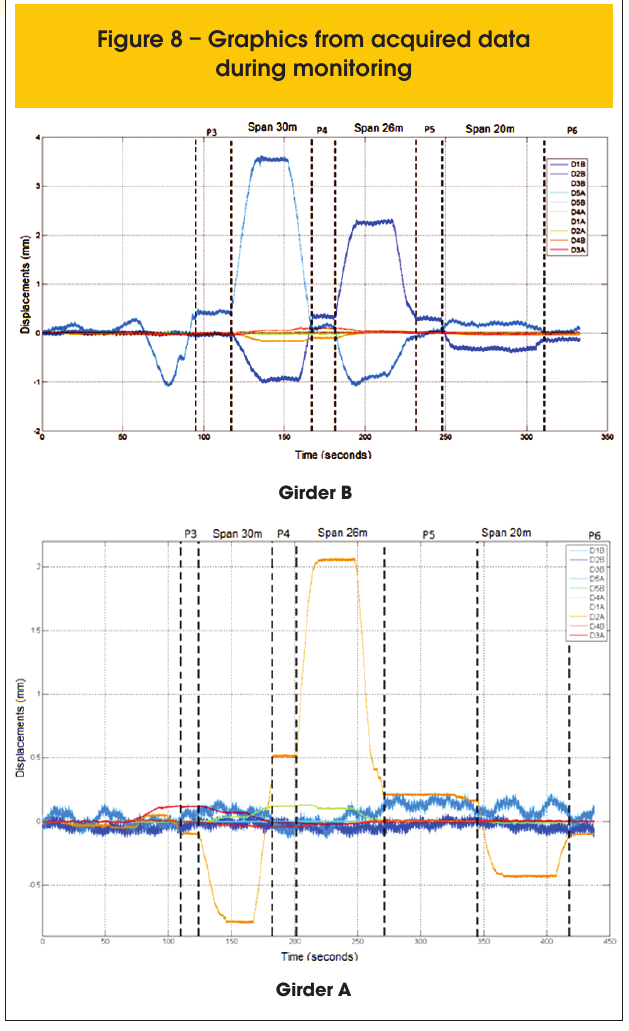
Figure 8 – Graphics from acquired data during